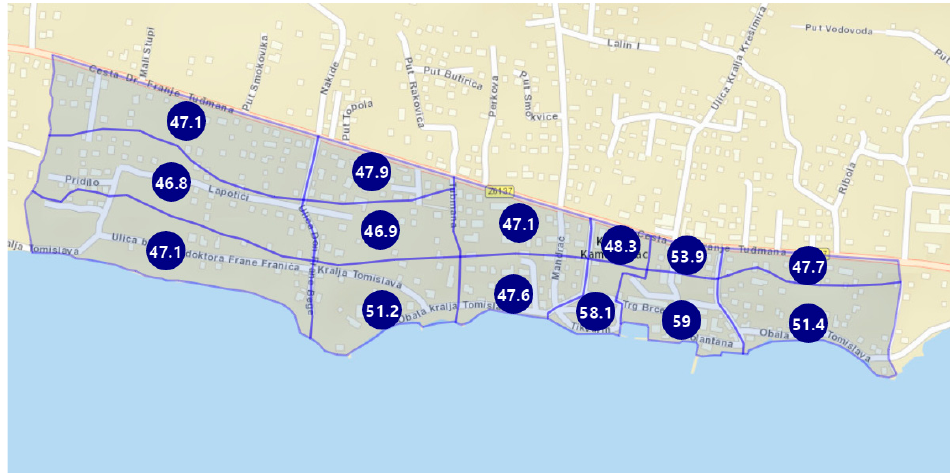
Figure 15. Results of risk analysis for seismic and flood hazard for Level 1 (Scenario S-F L1).